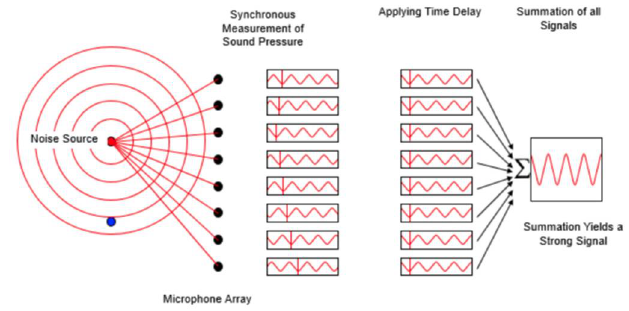
Figure 13. Beamforming algorithm focused on sound sources.